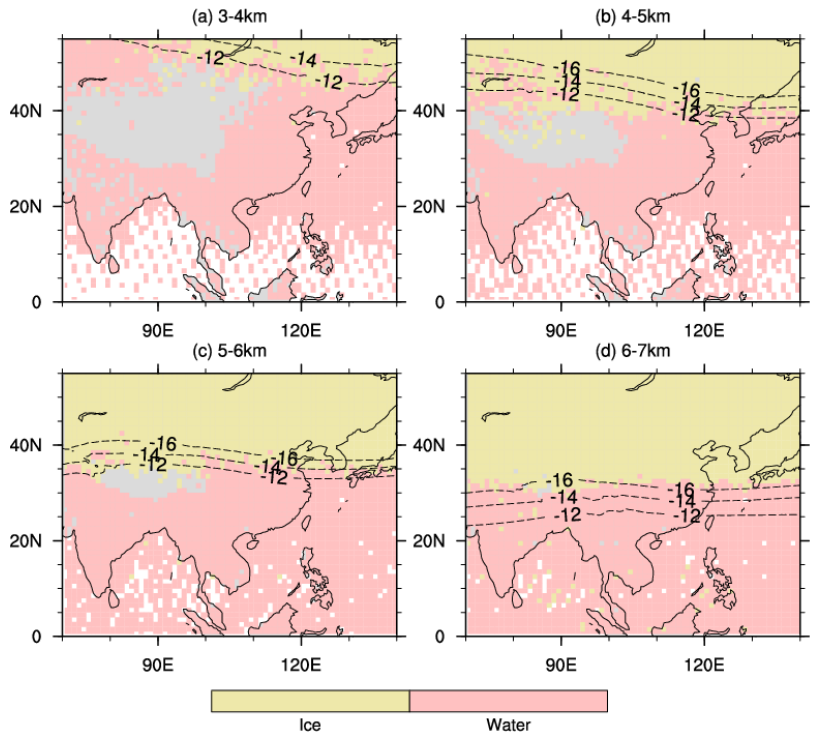
Figure 10. Prevailing cloud phase–temperature distribution at different altitude layers: ( a ) 3–4 km, ( b ) 4–5 km, ( c ) 5–6 km, and ( d ) 6–7 km. The shading is the prevailing cloud phase distribution, and the black dashed lines are contour lines from − 12 °C to − 16 °C.